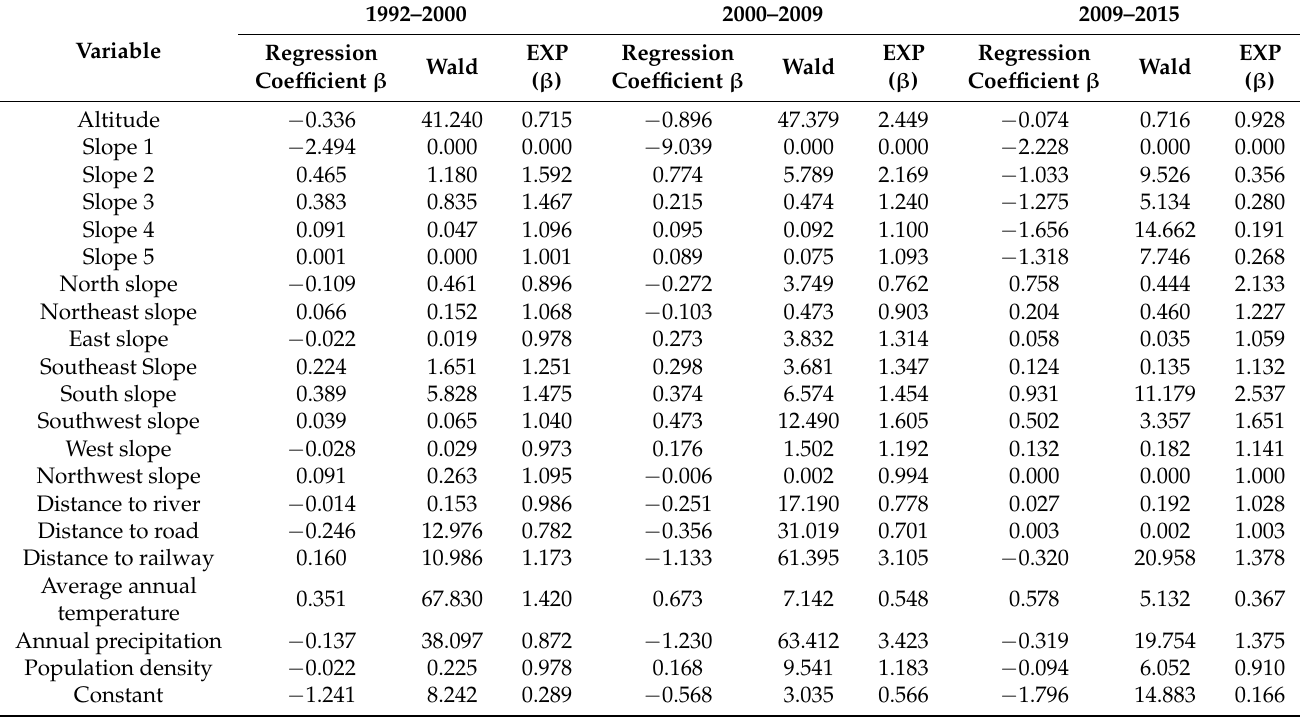
Table A4. Model estimates for Coniferous Forest land contraction driving forces.